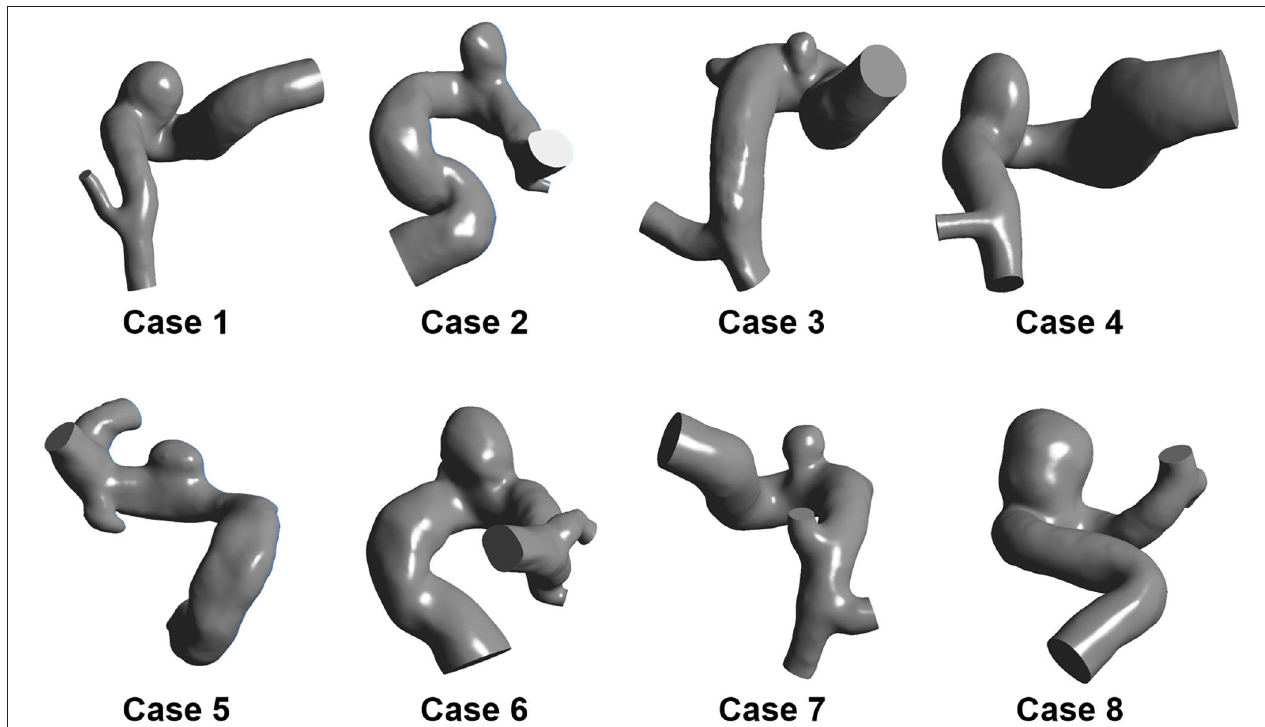
FIGURE 1 | Eight patient-specific IA